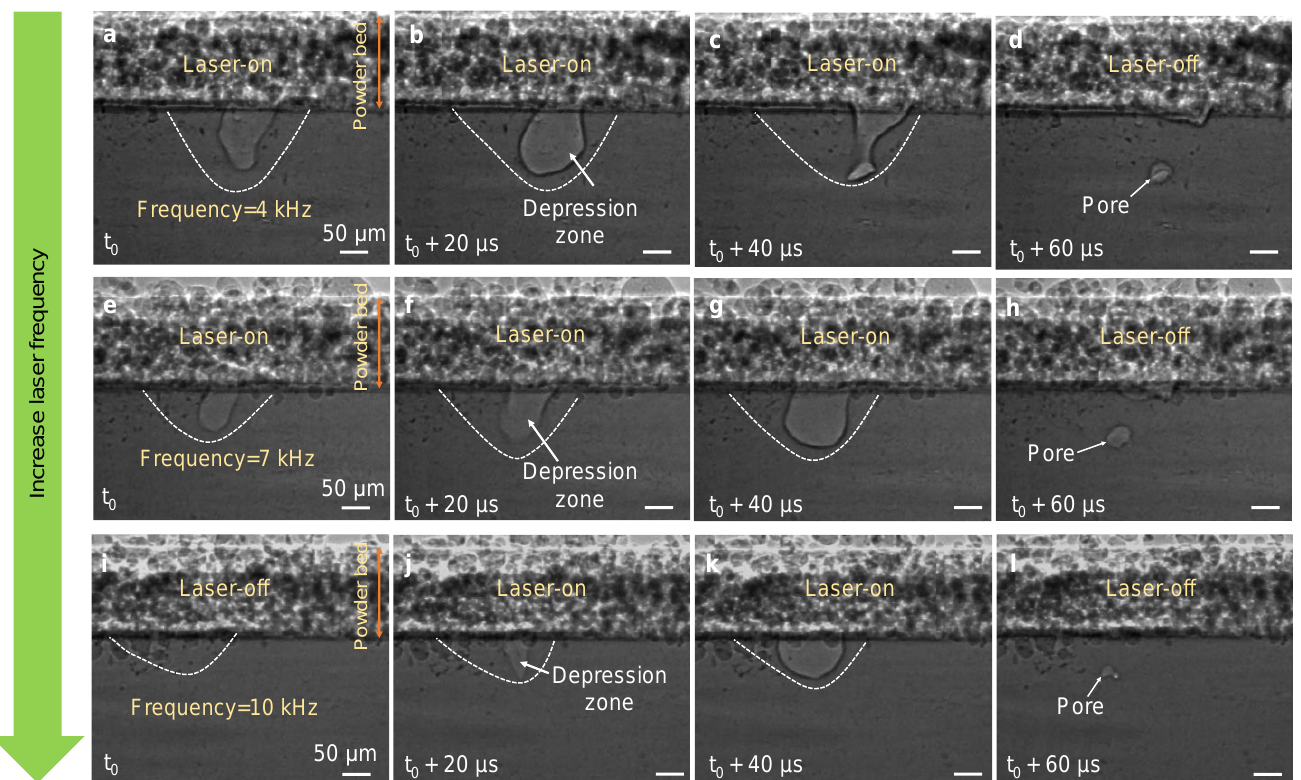
Figure 2. Pore formation under varying laser frequencies at a constant laser duty cycle: ( a – l ) Dynamic X-ray images showing pore formation during the PW-LPBF of Al6061 at laser frequencies of 4 kHz ( a – d ), 7 kHz ( e – h ), and 10 kHz ( i – l ) under a laser duty cycle of 50%, a laser power of 470 W and a scan speed of 0.4 m/s. In d, h and l, the melt pool boundary is not indicated to avoid blocking the view of the pores. Note that images do not display the complete duration of one pulse. The compiled movies showing the complete duration of two consecutive pulses are available in the Supplementary Material (Movies S1 – S3).